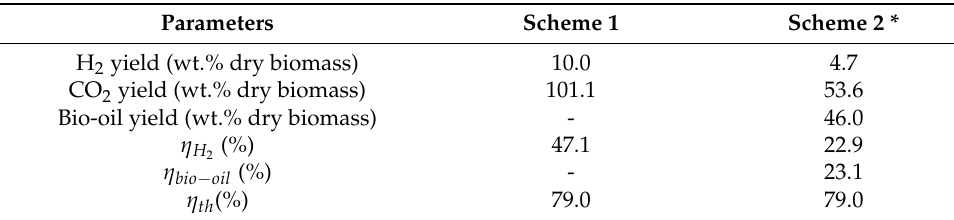
Table 7. Product yields and efficiencies of Schemes 1 and 2.